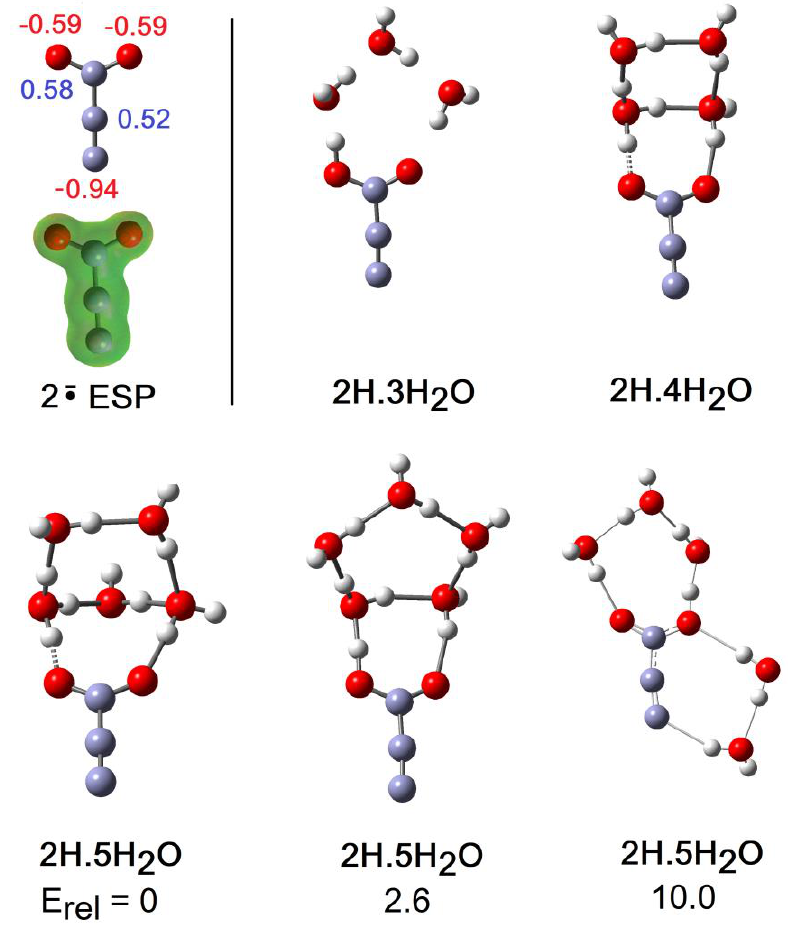
Figure 5. Optimized Structures of Hydration Clusters for Carboxy-ethynyl Radical 2H and Radical Anion 2 . Mulliken charge: negative in red, positive in blue.